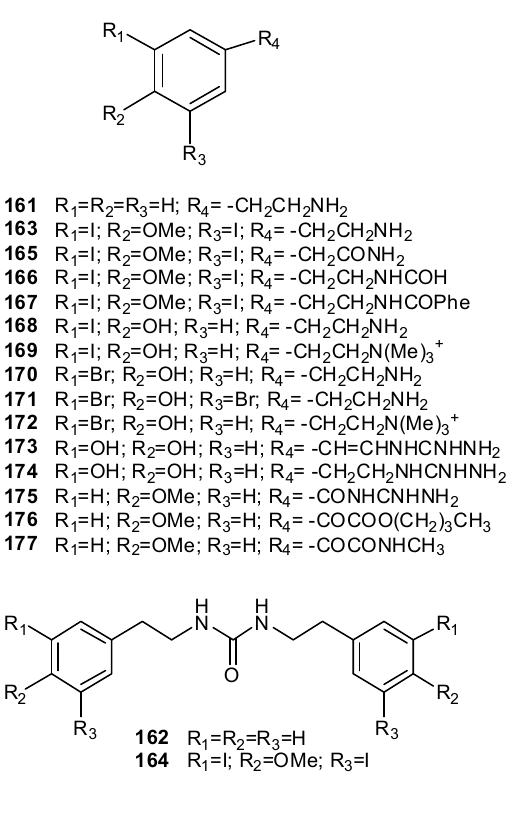
Figure 19. Iodinated and/or brominated tyramine